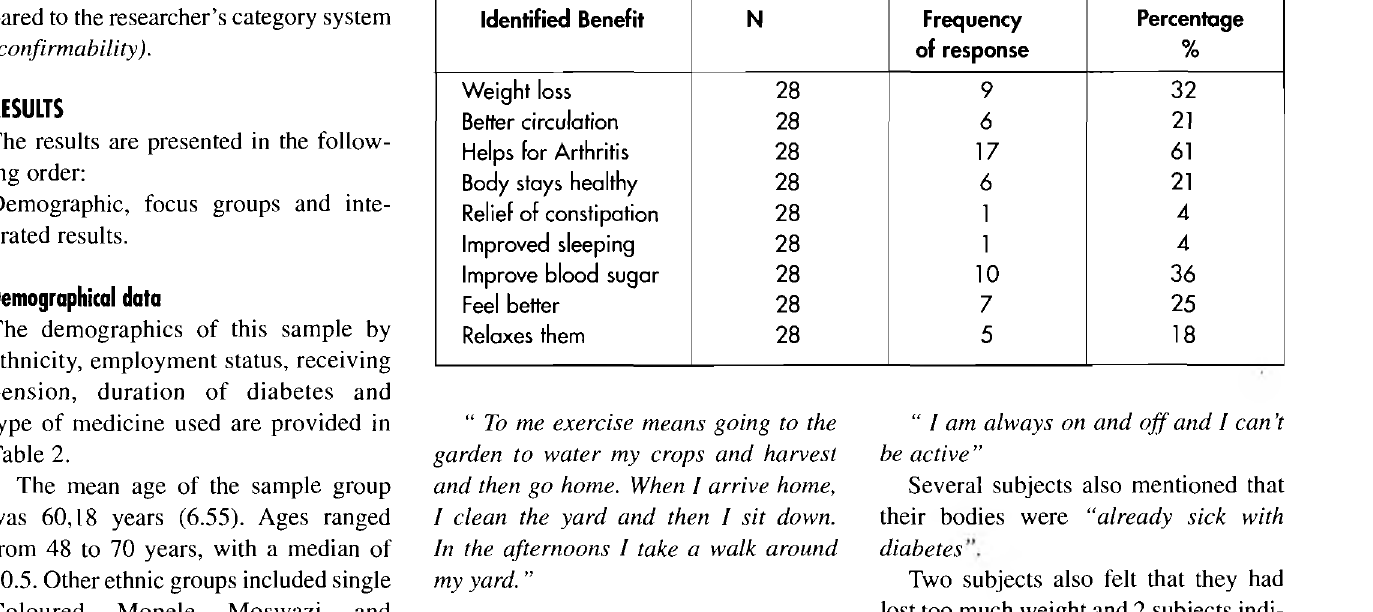
Table 3: Summary of identified benefits of exercise.